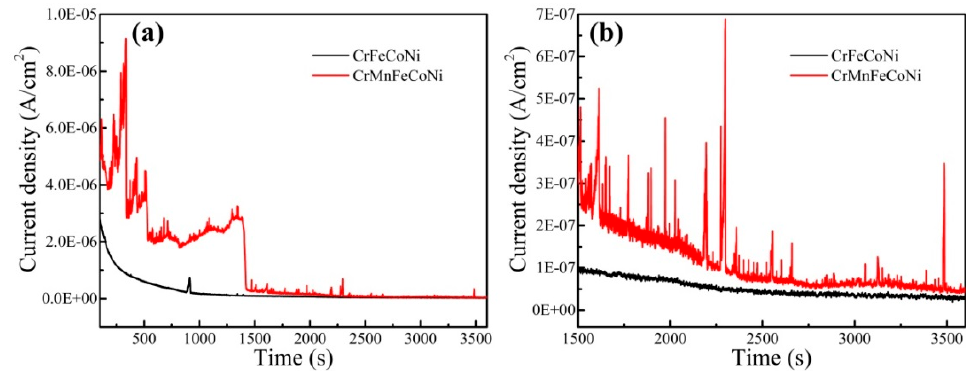
Figure 7. Current-time transient curves of the CrFeCoNi and CrMnFeCoNi coatings at applied voltage of − 0.1 V SCE in 3.5 wt% NaCl solution: ( a ) Current-time transient curve; ( b ) Local current-time transient curve